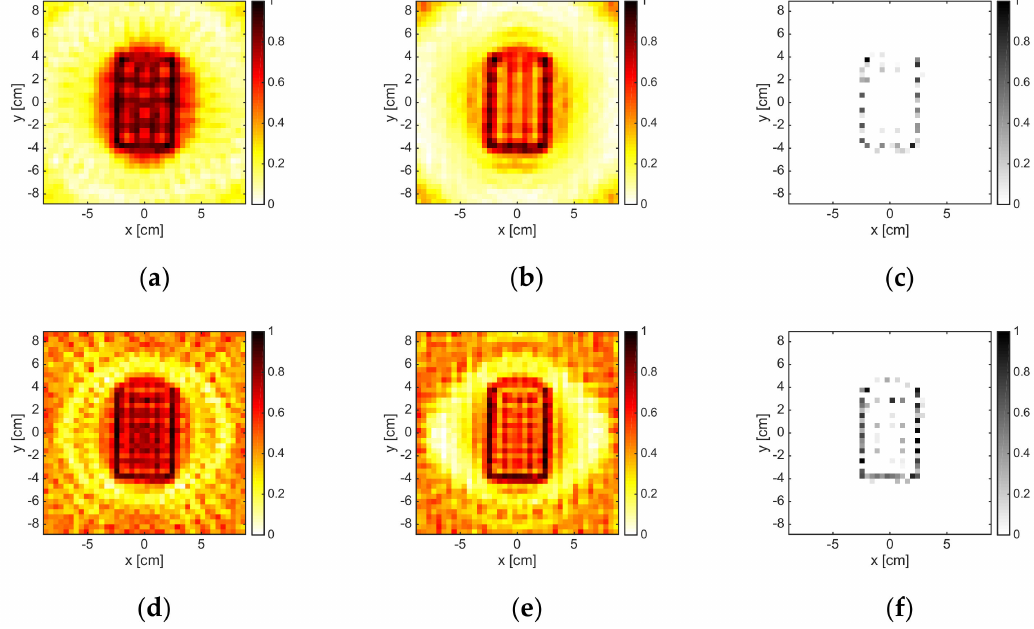
Figure 7. The U-TM-shaped target. From top to bottom: 12 GHz and 16 GHz. From left to right: LSM, OSM, and B-IS indicators. The number of measurements and views was